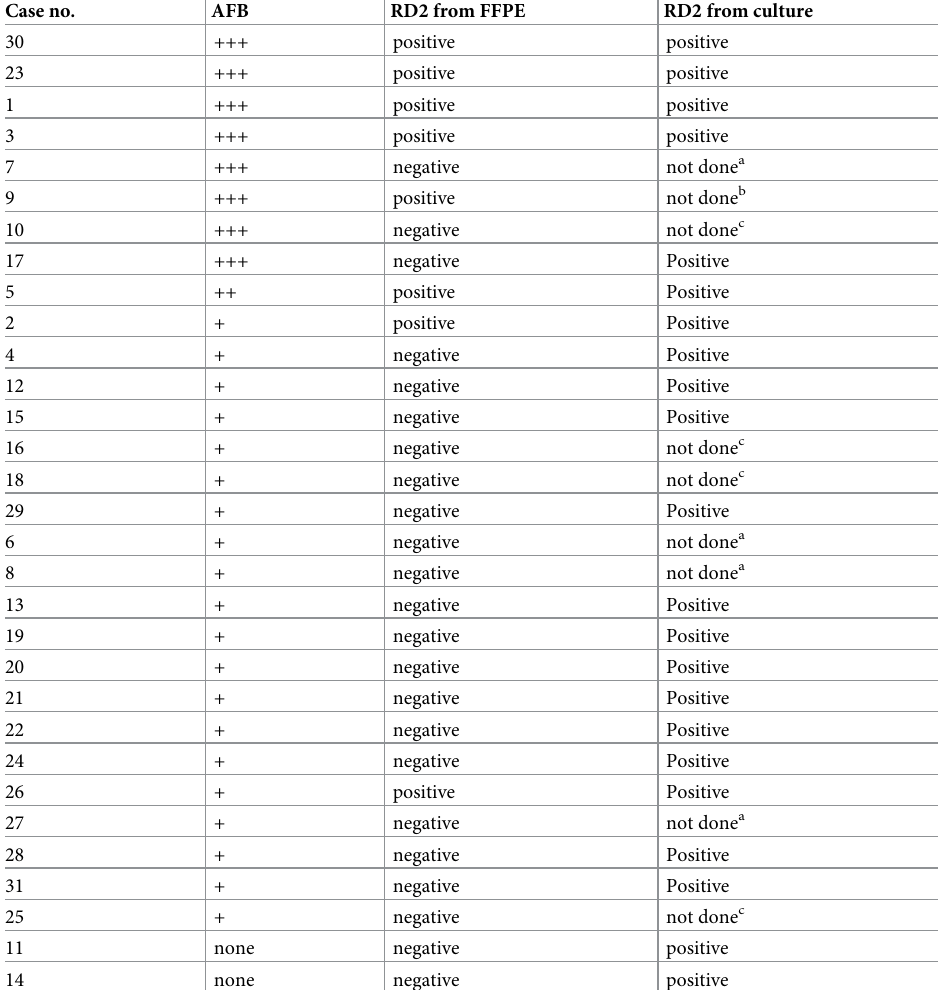
Table 3. RD2 results using DNA from formalin-fixed tissues and cultures. Case no.